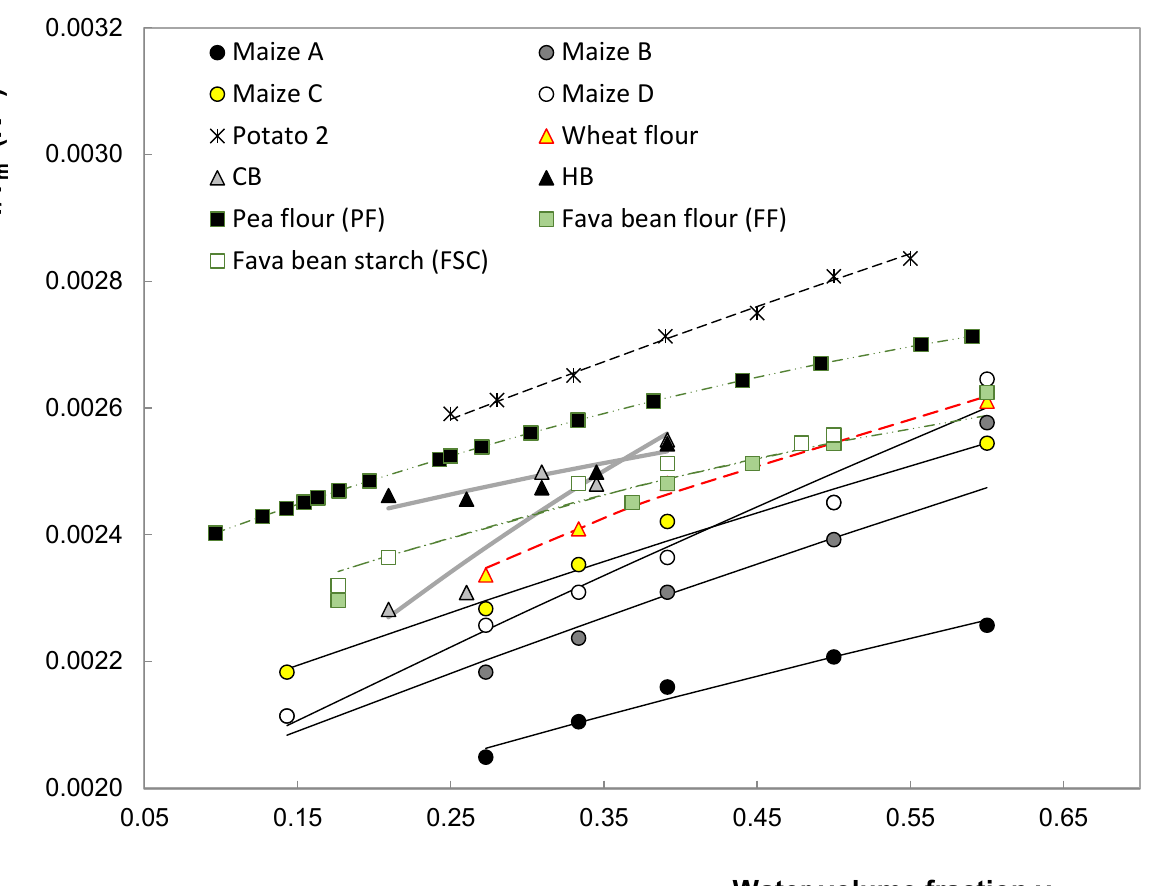
Figure A3. Inverse of melting temperature (T m ) as a function of water volume fraction v. The points refer to melting temperature obtained as the maximum temperature of an endothermic peak of DSC. The curves represent the best fit using the Flory–Huggins equation